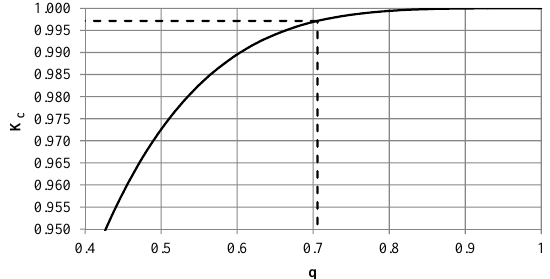
Fig. 3. Simulated relationship between the Kendall’s distribution function K C and the critical level q (solid line). The dashed line represents a KRP of 100yr given by K C = 0.997142 for a critical level of q =